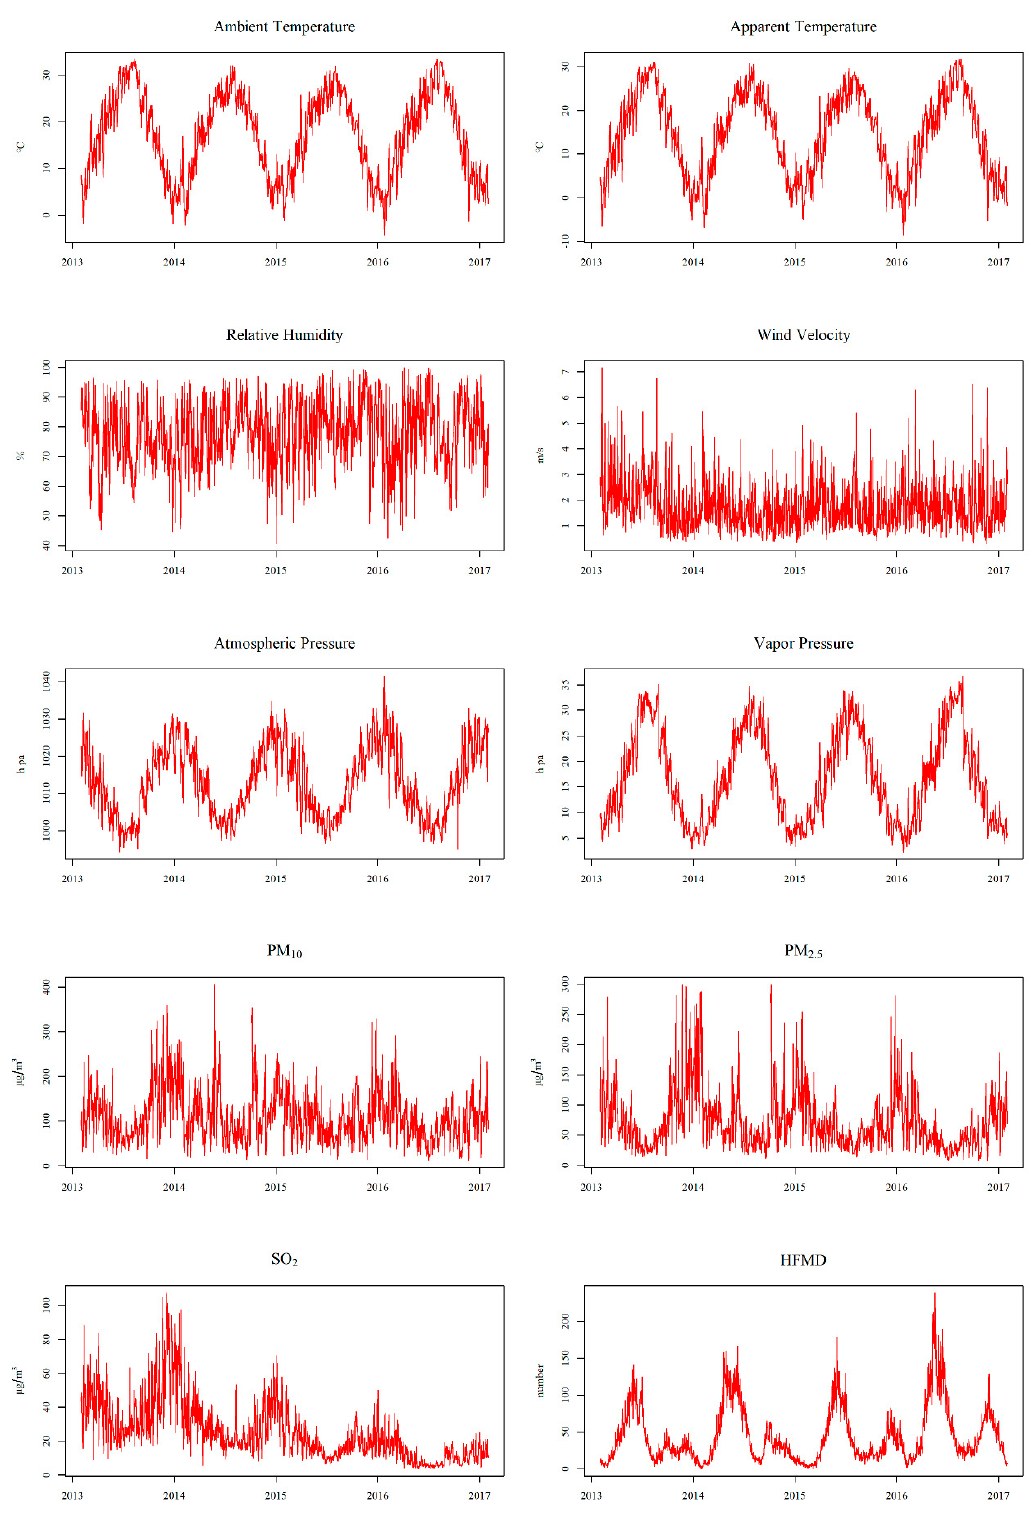
Figure 1. Seasonal fluctuations in meteorological factors, air pollutants, and HFMD cases in Wuhan, China from 1 February 2013 to 31 January 2017.